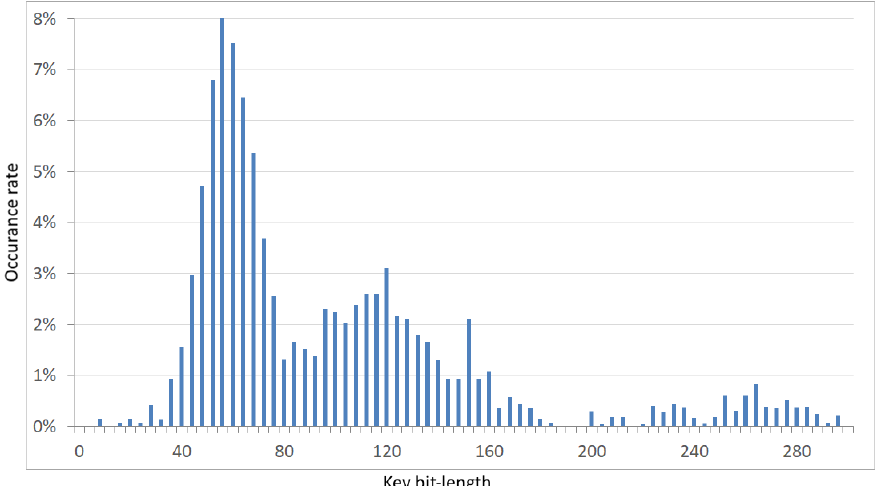
Figure 6. Histogram of the keys’ bit-lengths after a three-stage reduction of the initial boot-set of eight 512-bit random